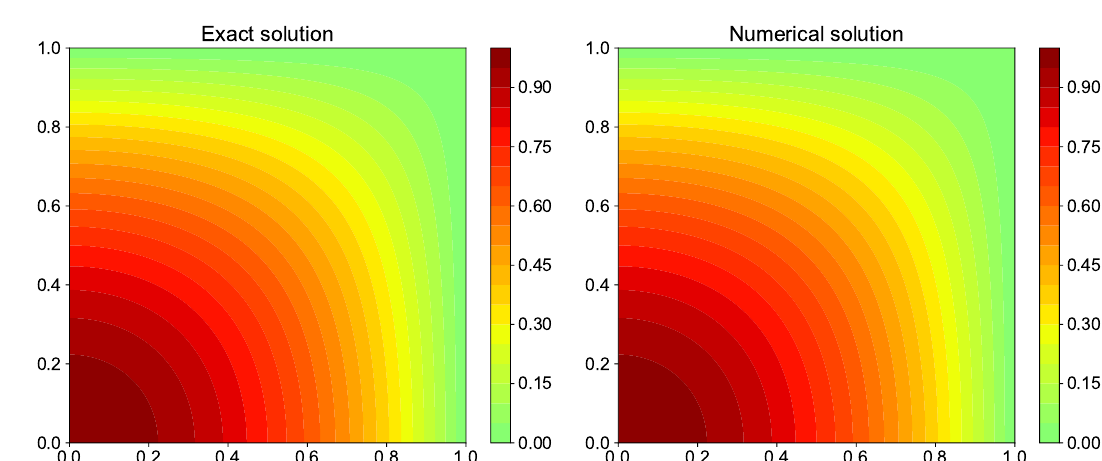
Figure 21. Comparison of exact solution and numerical solution computed using conjugate gradient algorithm for the Poisson